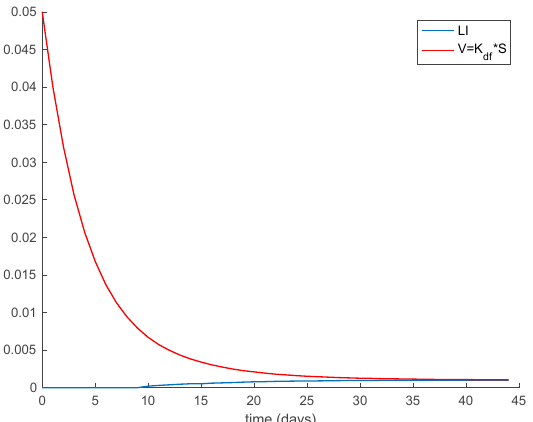
Figure 6. Satisfaction of Condition 3 from Theorem 1 in Case 1.3 conditions from (30).